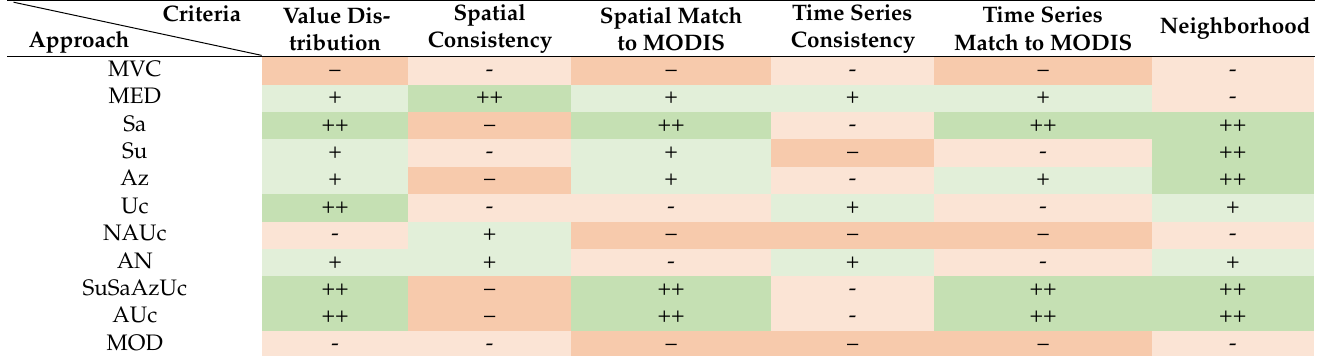
Table 2. Evaluation of compositing methods based on different criteria. If a criterion is well or very well fulfilled, it is marked with pluses (+/++); if a criterion is partly or completely unfulfilled, it is marked with minuses